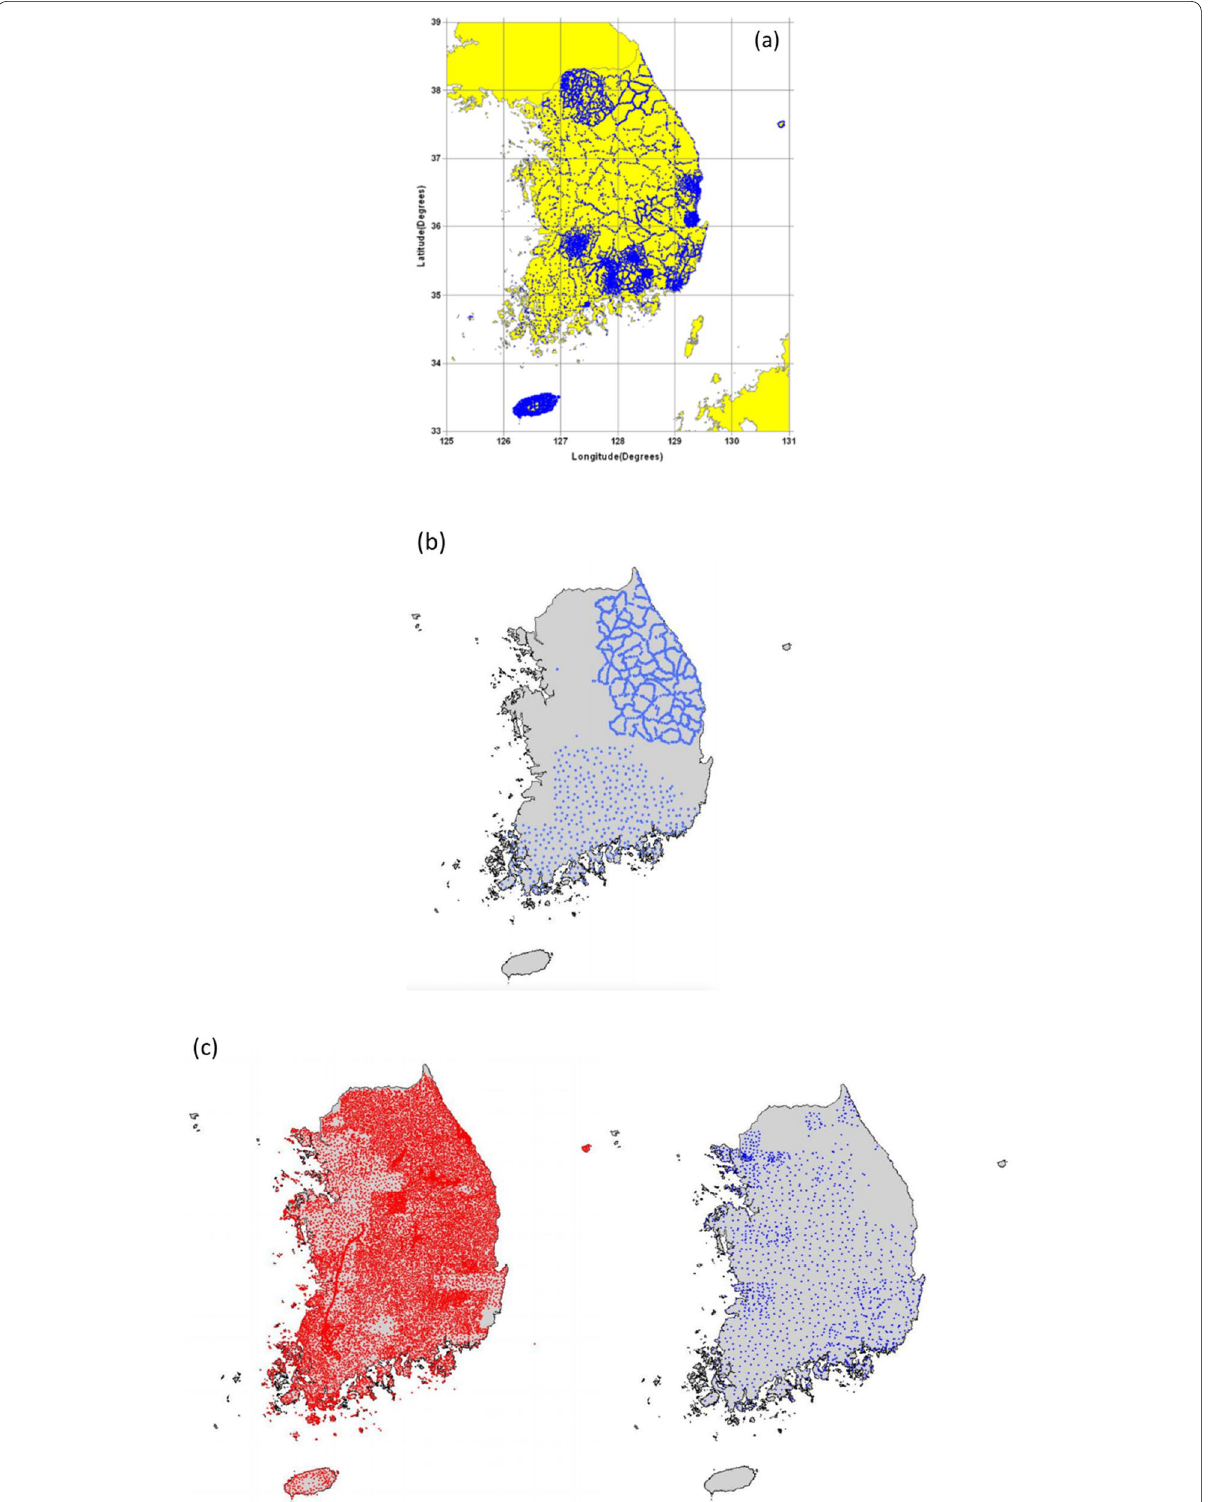
Fig. 1 a Terrestrial gravity data for NORI05 (Lee et al. 2005). b Terrestrial gravity data and c GNSS/Leveling data for GMK09 (Heo et al.